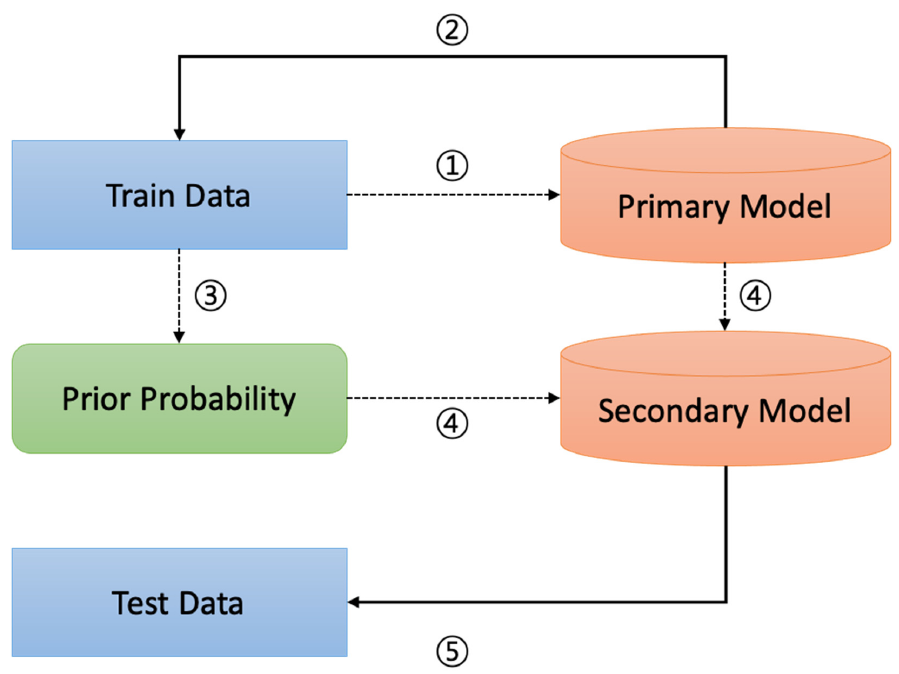
Figure 8. Prior probability estimation method of existing study.